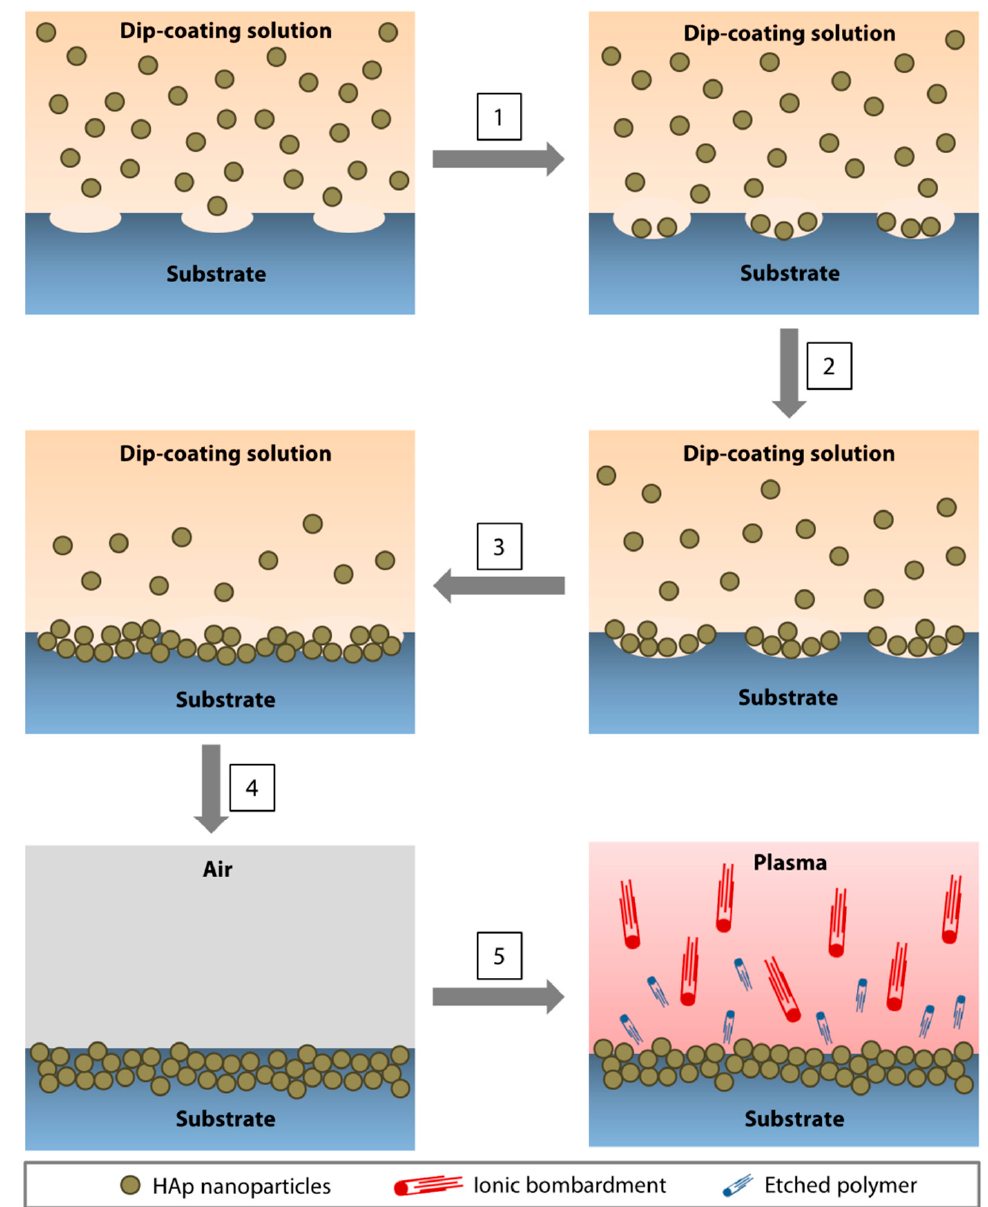
Figure 3. Direct immobilization of HAp nanoparticles via dip-coating method. ( 1 ) As the polymeric surface was softened by the organic solvent, pores started to form, followed by the deposition of the nanoparticles in the pores. ( 2 , 3 ) The pores enlarged as the dip-coating progressed and an increasing amount of nanoparticles accumulated in the cavities. ( 4 ) At the conclusion of the dip-coating, the substrate was air-dried. During the drying process, the ‘liquified’ surface began to resolidify, immobilizing the nanoparticles near the surface of the substrate. ( 5 ) Oxygen plasma treatment resulted in ion bombardment of the surface, removing contaminants, and etching away the polymer that masked the nanoparticles during the drying step. An increasing amount of HAp nanoparticles emerged as the residual polymer was etched.